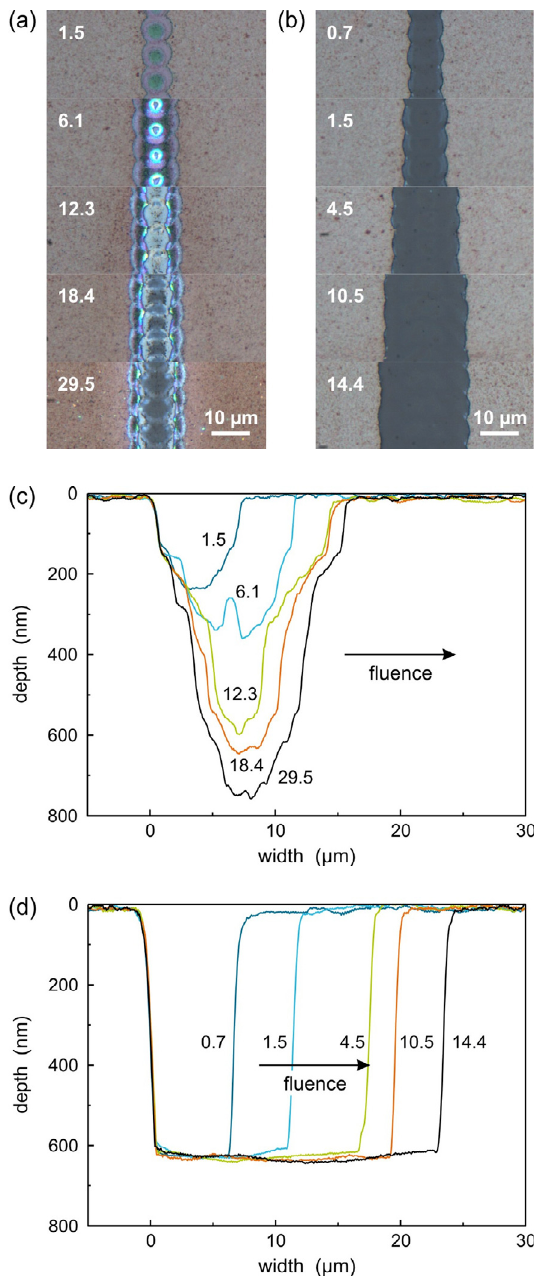
Fig. 2. Microscope images (a, b) and cross-sectional profiles (c, d) of ablation lines; obtained after irradiation from the TCO side (a, c) or from the glass side (b, d). All numbers labeling the microscope images or depth profiles are fluence values in J/cm 2 .